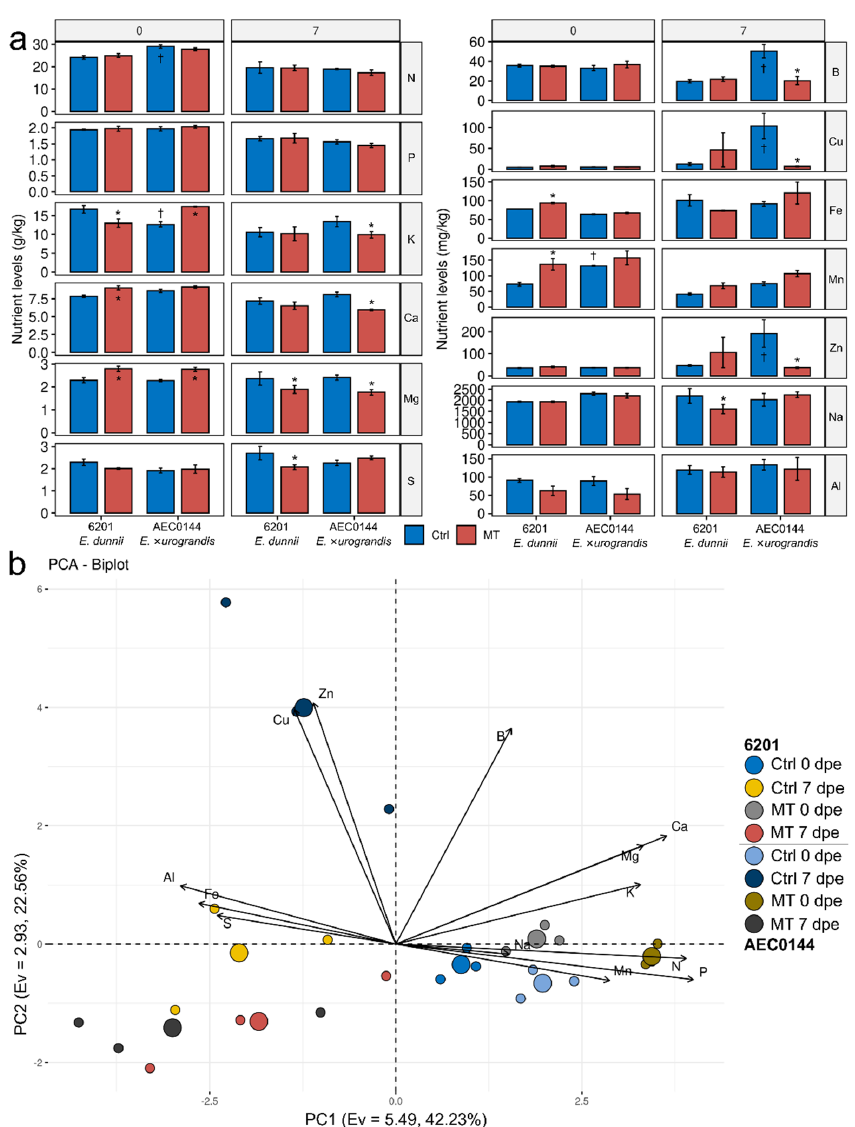
Figure 7. Foliar nutrient profiles of Eucalyptus dunnii 6201 (hardR) and E. × urograndis AEC0144 (easyR) at the time of and post-cutting excision. (a) Levels of N, P, K, Ca, Mg, S (g/kg DW), B, Cu, Fe, Mn, Zn, Na, and Al (mg/kg DW) in the mini-stumps (0 days post excision, dpe) under control (Ctrl) and mini ‐ tunnel (MT) conditions and respective cuttings (7 dpe). Bars represent mean ± SEM. Asterisks (*) and daggers (†) mark signi fi cantly di ff erent nutrient levels between treatments and species at each timepoint, respectively (factorial ANOVA, estimated marginal means test, n = 3–4, p ≤ 0.05). DW = dry weight. ( b ) Principal component analysis of foliar nutrient levels. Axes represent principal components (PC) with the corresponding eigenvalues (Ev) and percentage of variance ex ‐ plained. Regular circles represent biological replicates ( n = 3), while larger ones are the centroids for each group indicated in the legend. The distance between Ctrl–MT pairs indicates the impact of the treatment on cut ‐ ting foliar nutritional status. At 0 dpe, an MT ‐ associated rightward shift from the Ctrl could be seen in both clones. Similarly, an MT downward displacement from the Ctrl was visible at 7 dpe. The baseline fertilization was different at 0 and 7 dpe, and the data from each timepoint were grouped on each side of the PC1 axis. The grouping of the 0 dpe data